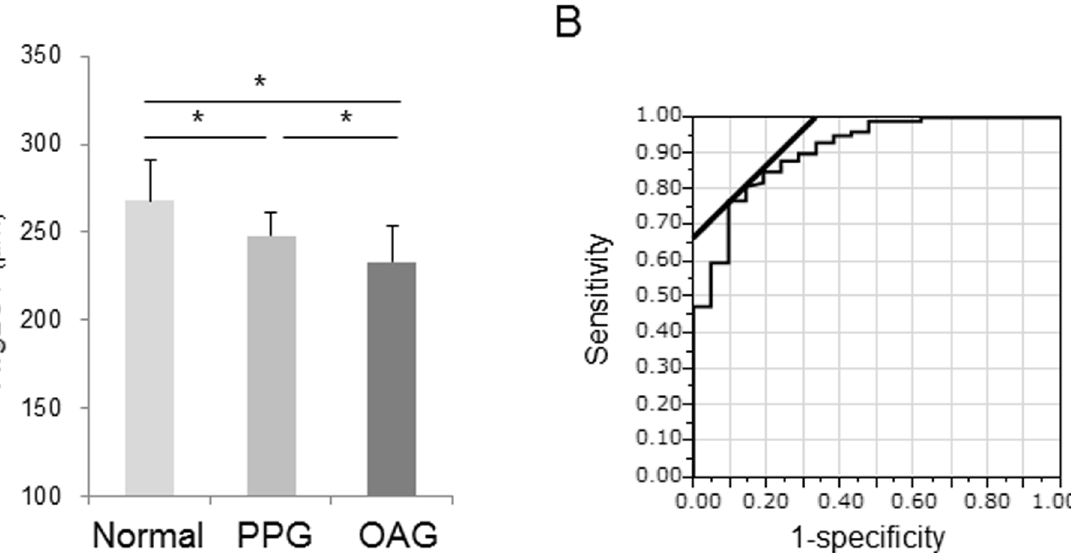
Fig 6. AvgLCT measurements made with the simplified version of the software. (A) Bar graph indicating LC thickness in patients with different stages of glaucoma (normal: n = 22, PPG: n = 28, OAG: n = 100). Note: there were significant differences between these groups (Kruskal-Wallis test followed by Steel- Dwass test). * : P < 0.01. (B) ROC curve. The area under the ROC curve was 0.91, with a cutoff value of 246.3 μ